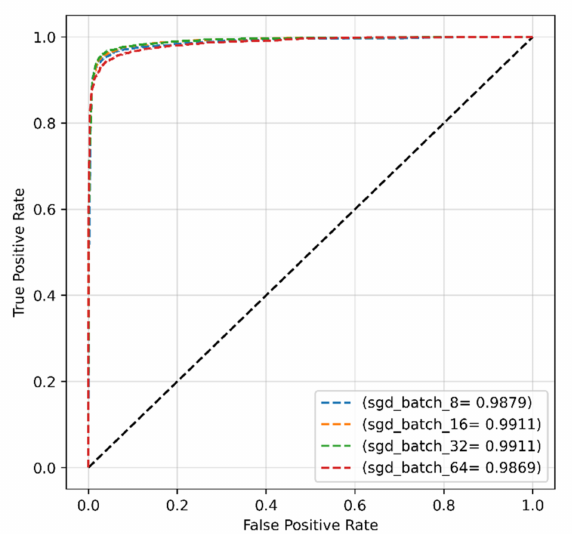
Figure 10. The ROC of the proposed model obtained with original dataset and SGD